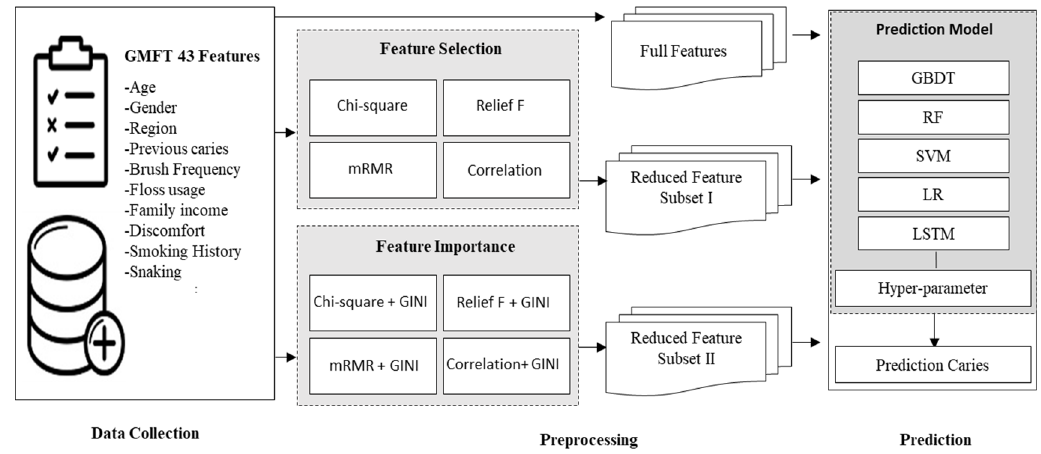
Figure 1. Proposed model for dental caries prediction.